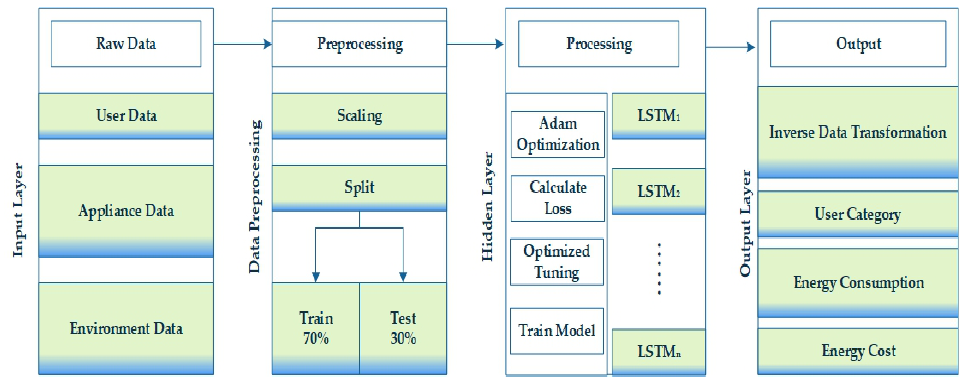
Figure 4. Overview of the prediction